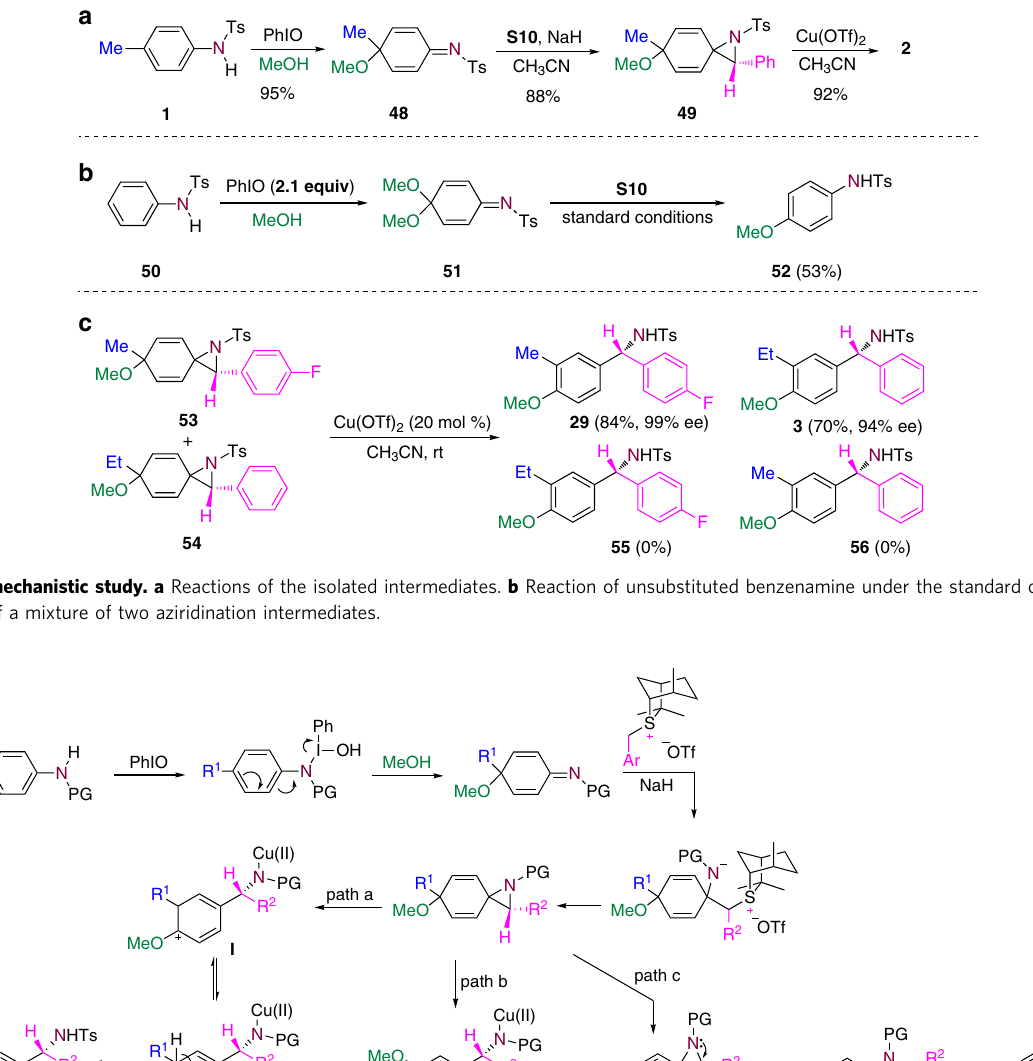
Fig. 7. PhIO mediates the oxidative dearomatization of para -